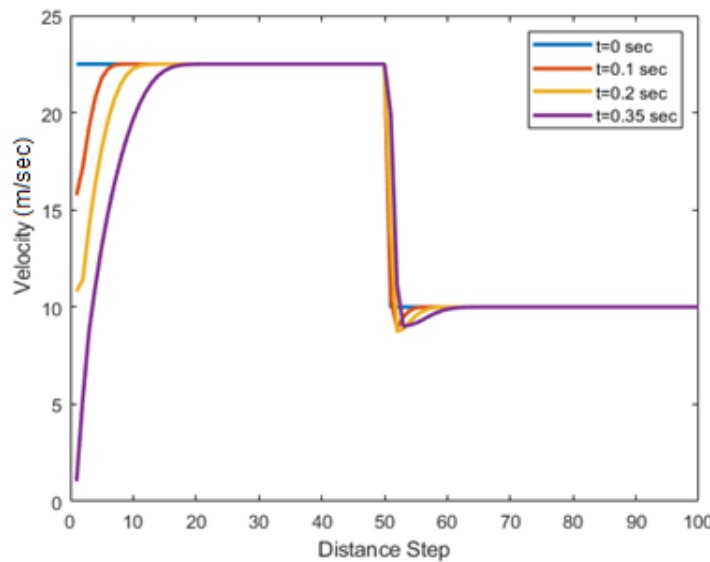
Figure 13. Velocity behavior of proposed model on straight road with no ingress traffic.